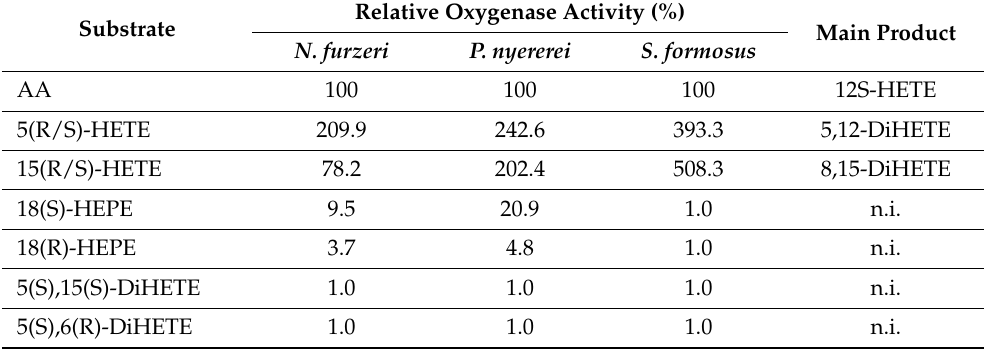
Table 1. Substrate specificity of bony fish ALOX-isoforms with oxygenated polyenoic fatty acids. Different oxygenated metabolites of polyenoic fatty acids were used for comparative activity assays. For these assays the different substrates were incubated in PBS (30 µM substrate concentration) and the rates of substrate conversion during a 10 min incubation period was assayed by RP-HPLC. The rate of AA conversion was set 100% and the relative conversion of the other substrates was calcu- lated. Cellular lysate supernatants were used as enzyme source and identical amounts of enzyme were added to the different substrates. n.i. not identified.